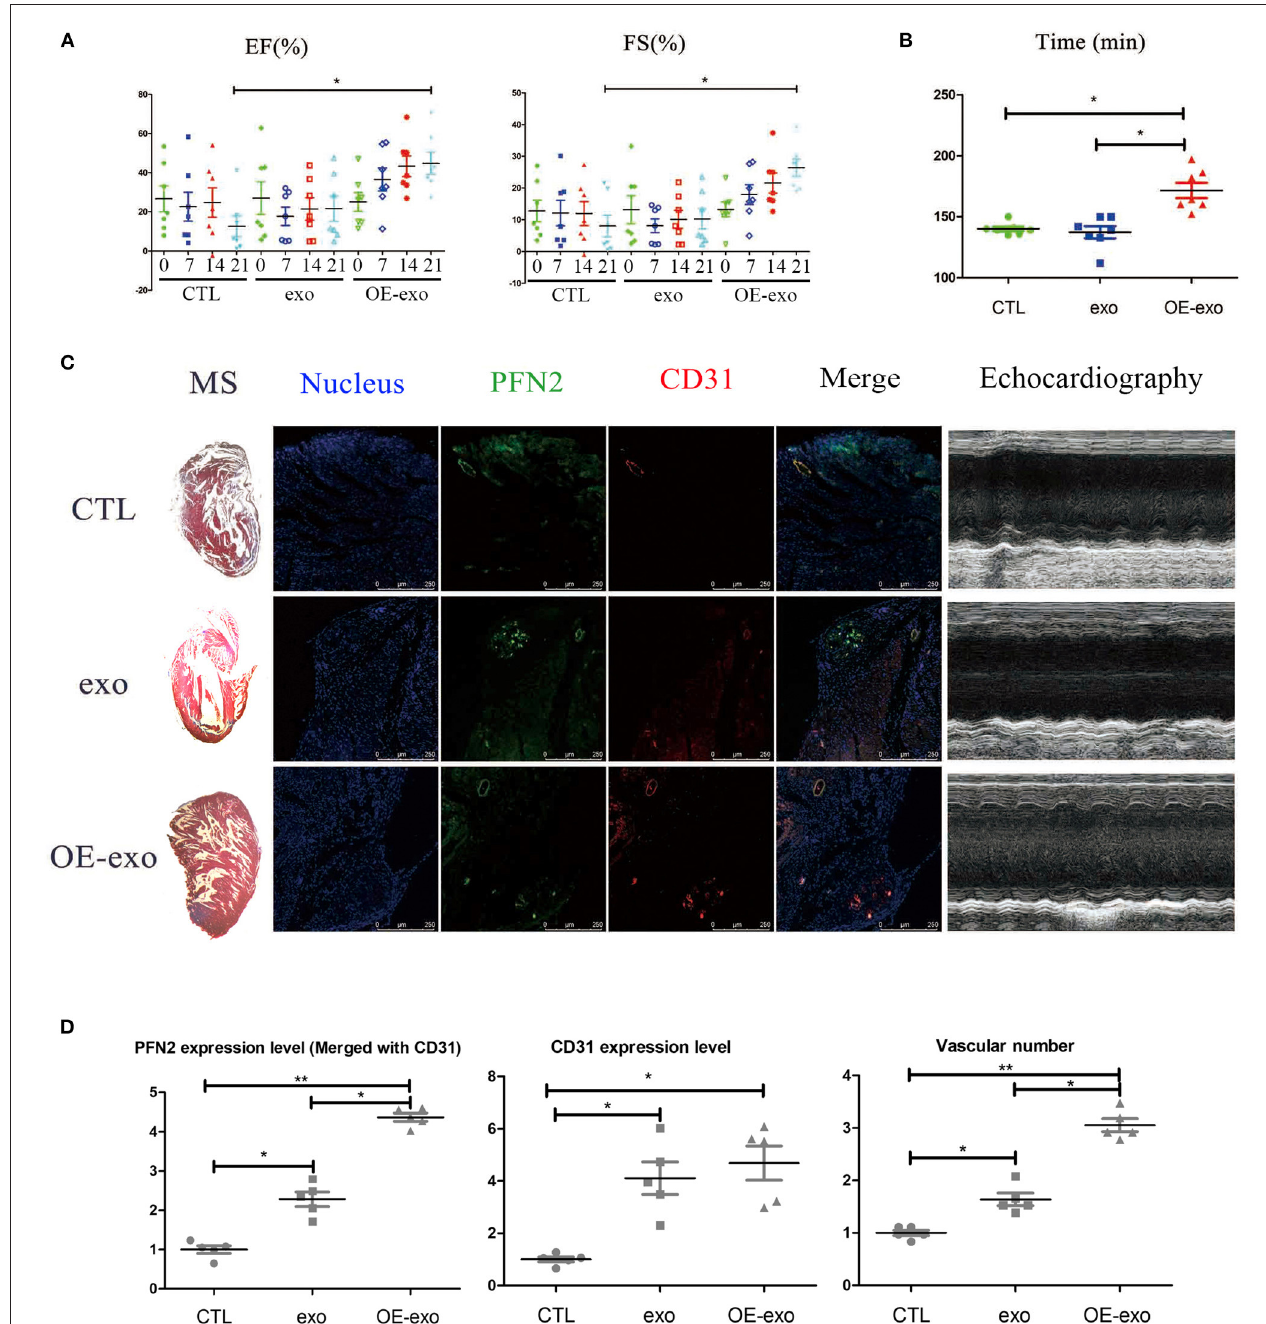
FIGURE 2 | Exosomal PFN2 repairs infarction in mouse with MI and restores cardiac function. (A) The cardiac function of mouse with MI as evaluated by type-B ultrasonic test EF and FS after treatment with exosomes demonstrated the benefit to MI impairment. (B) Physical fitness was evaluated by fatigue test after treatment with exosomes in mouse with MI which displayed significant improvement of heart function, n = 7. (C) Infarction volume (Masson’s staining) decreased and PFN2 (green)/CD31 (red) staining increased in heart tissue of mouse with MI after treatment with exosomes. (D) Statistical results of (C) . n = 3, normalized to control. * p < 0.05, one-way ANOVA